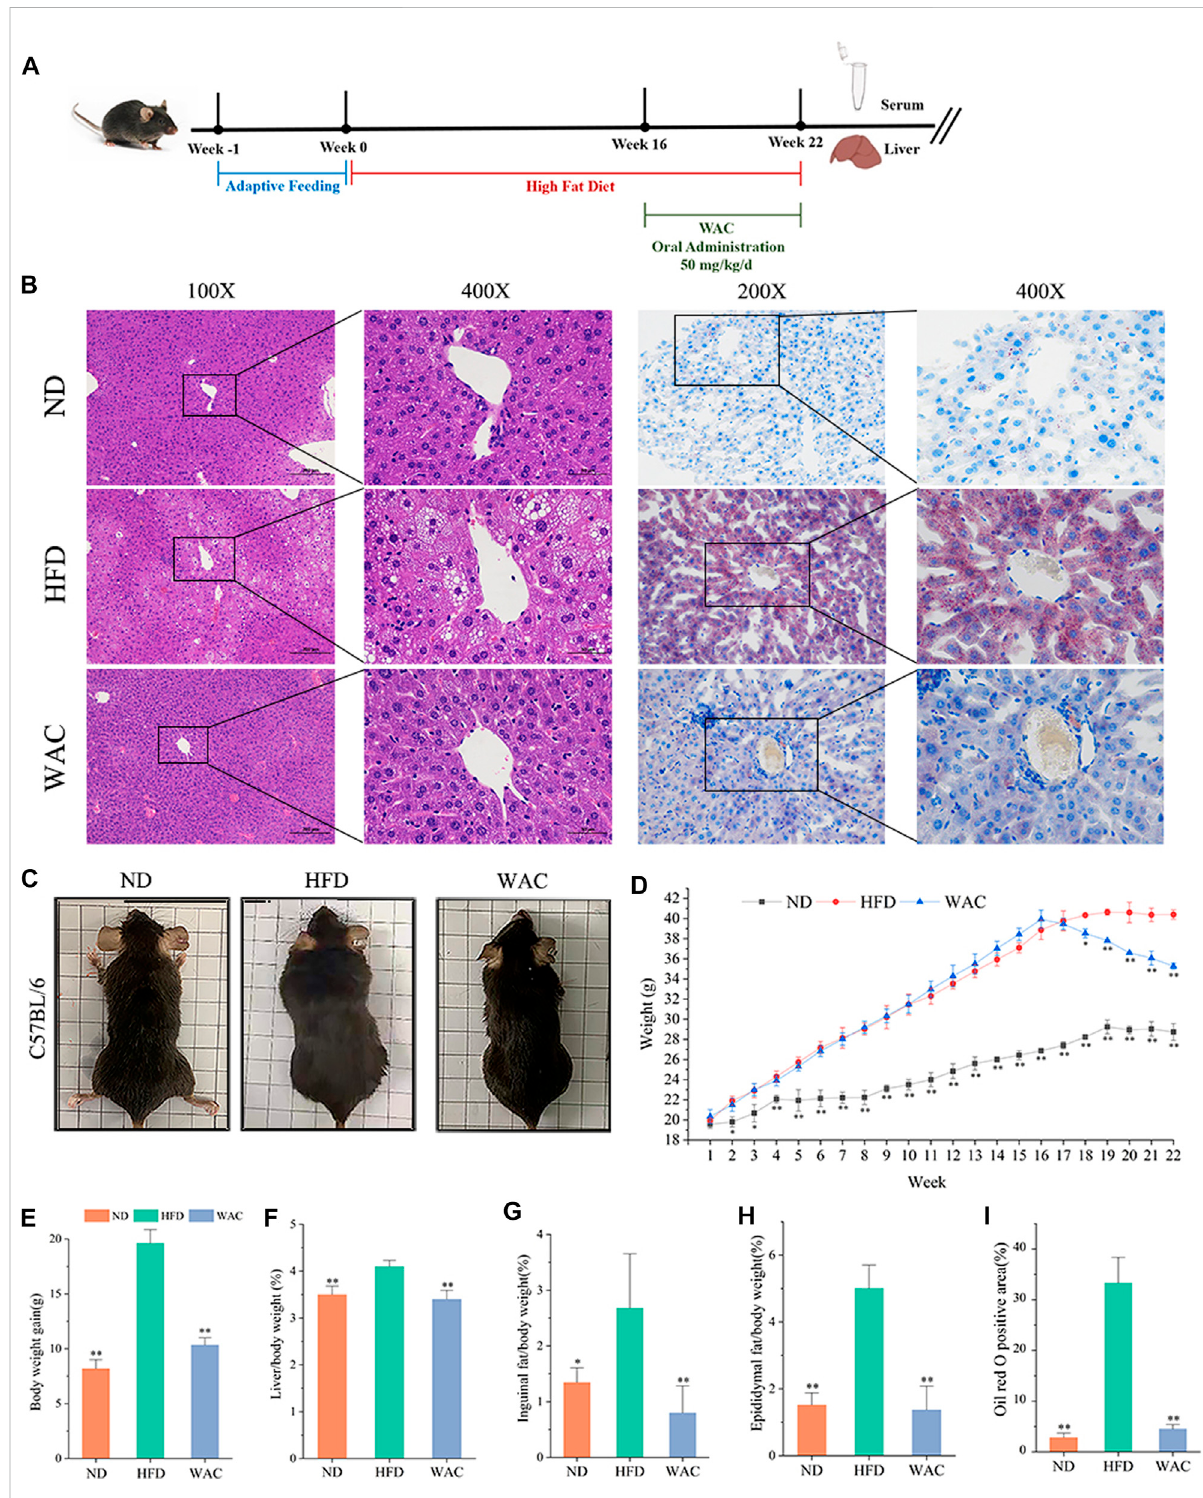
FIGURE 2 Effect of WAC on obesity and hepatic steatosis in HFD-induced NAFLD mice. (A) Animal experimentation process. (B) Pictures of liver morphology,HEstainingandoilredOstainingofliversectionsafter6 weeksofWACgavage. (C) Bodyconditionofmiceineachgroupafter6 weeks of WAC gavage. (D) Body weight changes in mice over 22 weeks. (E) Body weight gain in mice over 22 weeks. (F) Mouse liver index. (G) Index of inguinal adipose tissue in mice. (H) Adipose tissue index of mouse epididymis. (I) The positive areas of oil-red O staining were analyzed using ImageJ. Compared with HFD, * indicates p < 0.05 and ** indicates p <